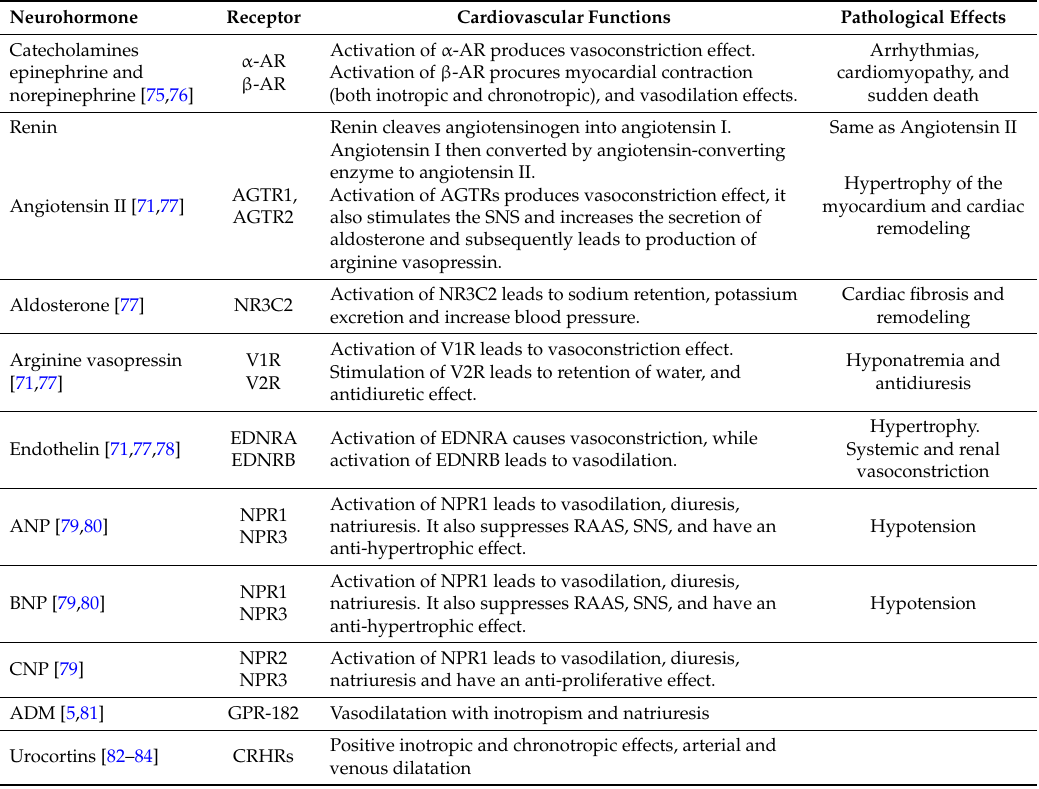
Table 2. Neurohormones in the cardiovascular